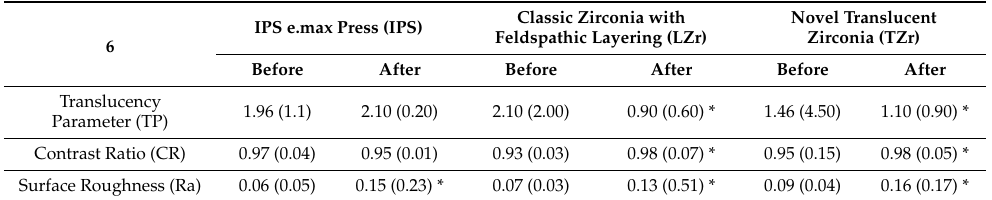
Table 2. Descriptive statistics of TP, CR, and Ra values pre- and post-bleaching, presented as median and interquartile range (IQR).